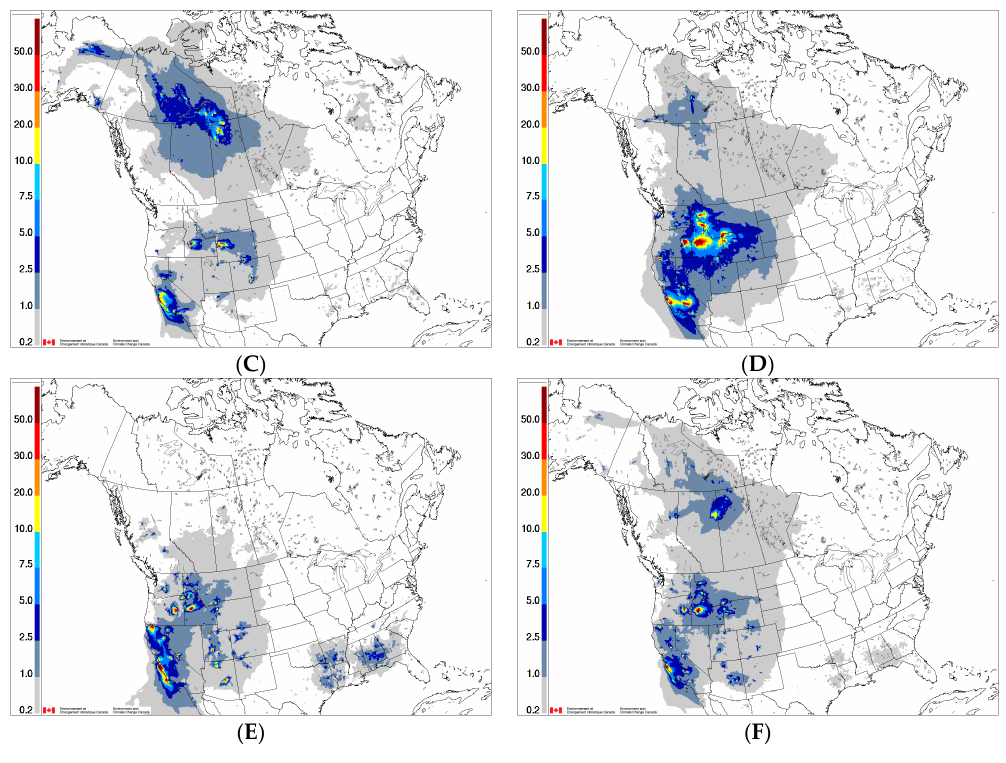
Figure 6. Same as Figure 3 but for 2016.